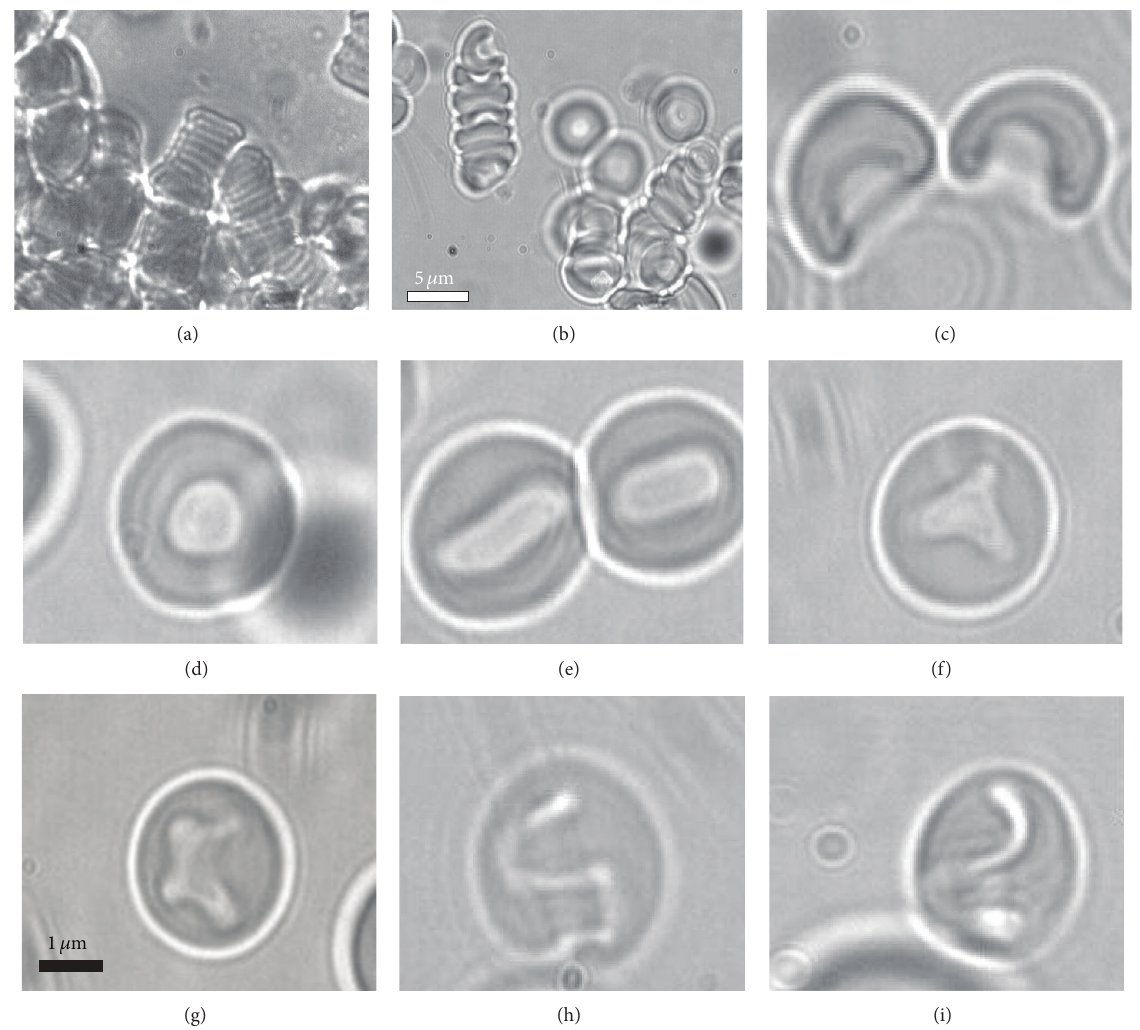
Figure 3: Effect of the local anesthetic lidocaine/epinephrine (L/E) on the erythrocyte shape. (a) Erythrocyte rouleaux formed in blood plasma, (b) erythrocyte rouleaux formed in blood plasma with added L/E, and (c) side view and (d)–(i) top view of different stomatocyte shapes found in blood dissolved in PBS with added